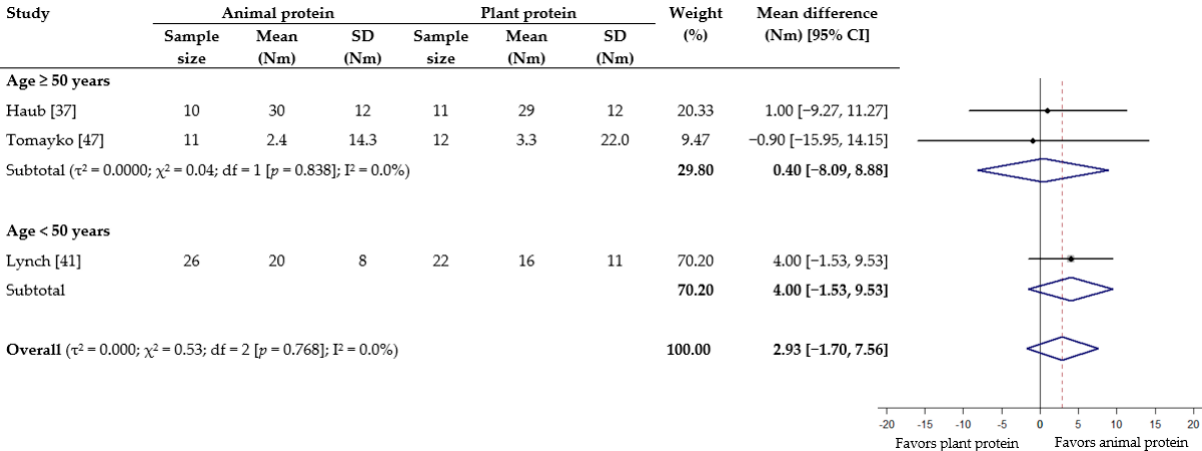
Figure 6. Effect of consuming animal protein compared to plant protein on changes in peak torque of leg/knee flexion (Nm) based on age group. Data expressed as weighted mean differences with 95% CIs, using a random-effects model. Nm: Newton meter.